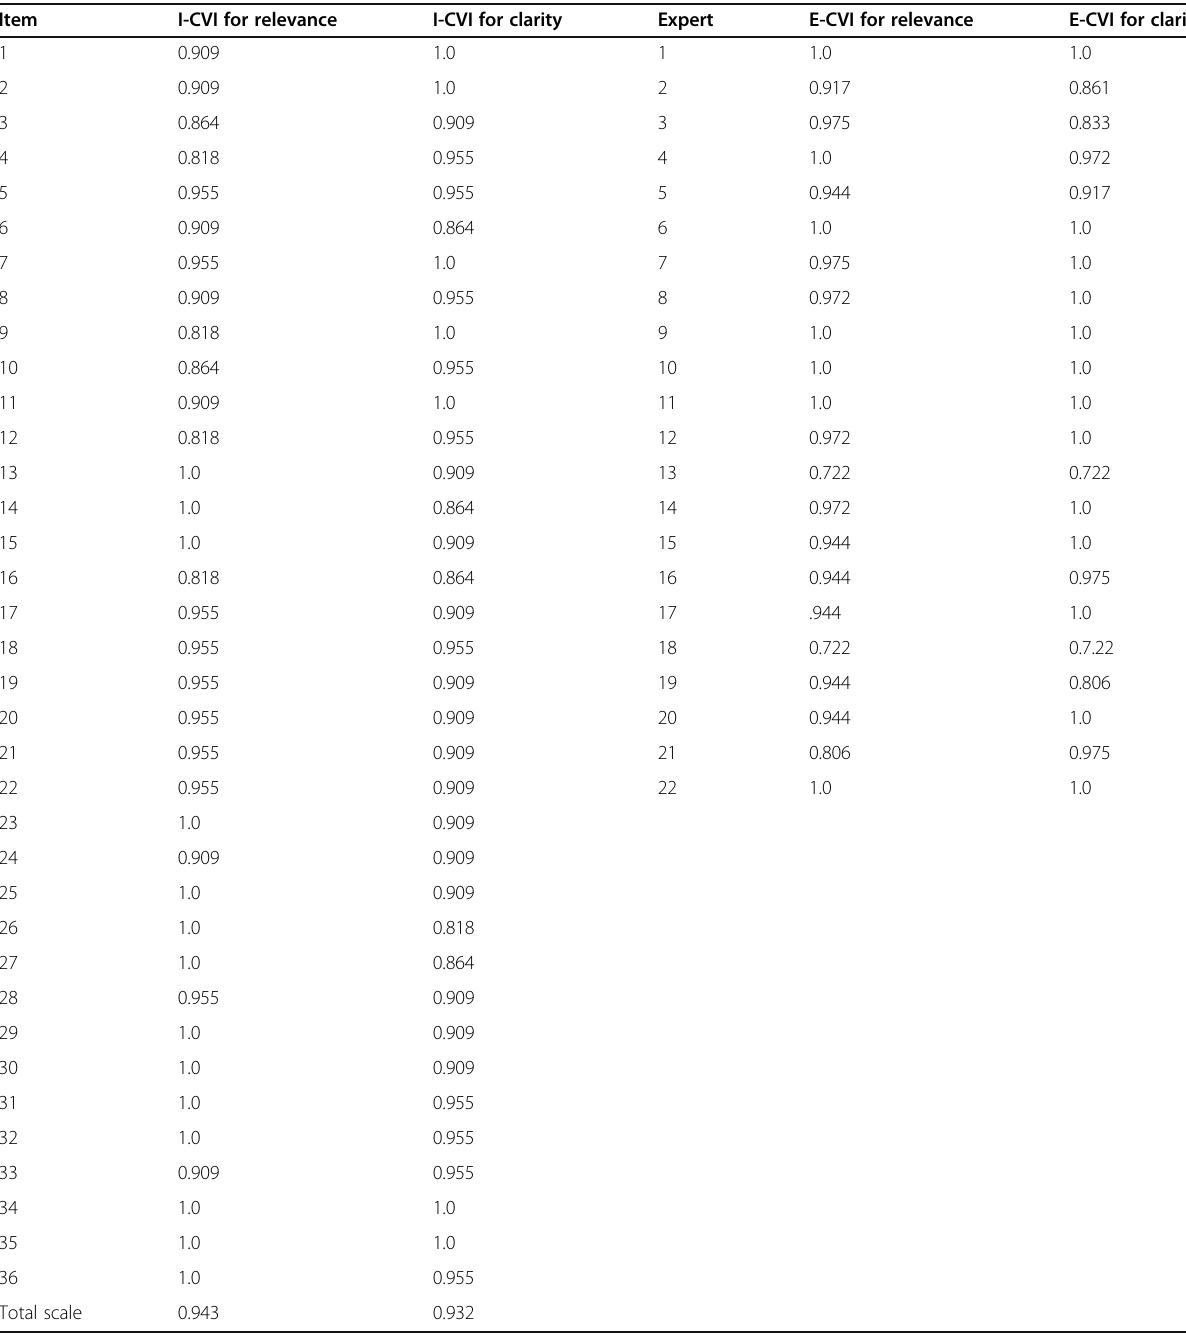
Table 1 Content validity indices (per item, per expert, and total scale) for both relevance and clarity of the